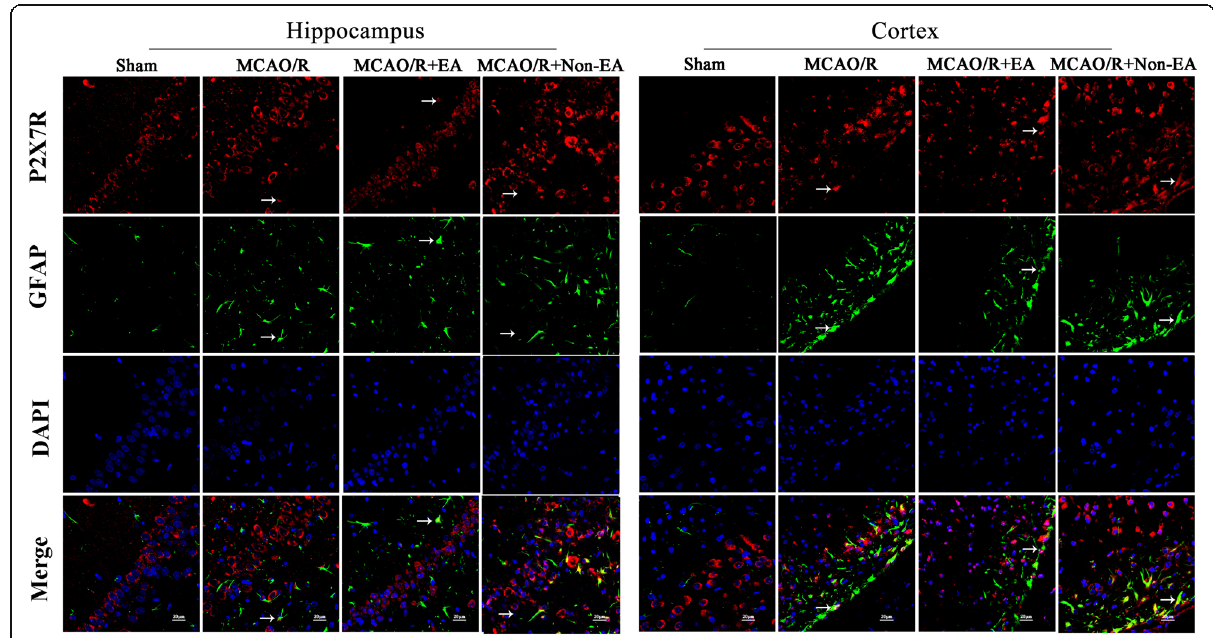
Fig. 7 Effects of EA on P2X7R and GFAP co-expression after MCAO/R injury. The co-expression of P2X7R and GFAP was examined in the hippocampal